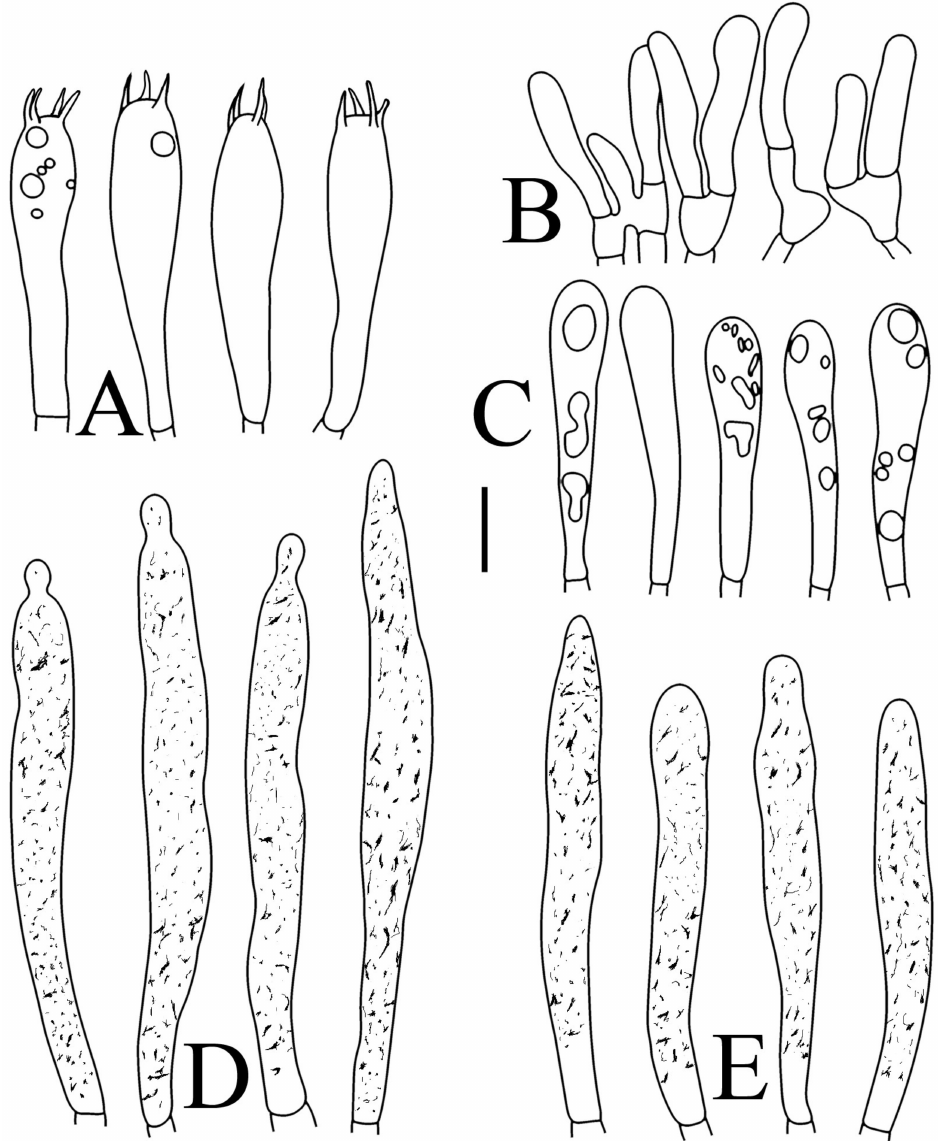
Figure 10. Russula pseudojaponica (RITF5755, holotype): ( A ) basidia; ( B ) marginal cells; ( C ) basidiola; ( D ) hymenial cystidia on lamellae sides; ( E ) hymenial cystidia on lamellae edges. Scale bars: 10 µ